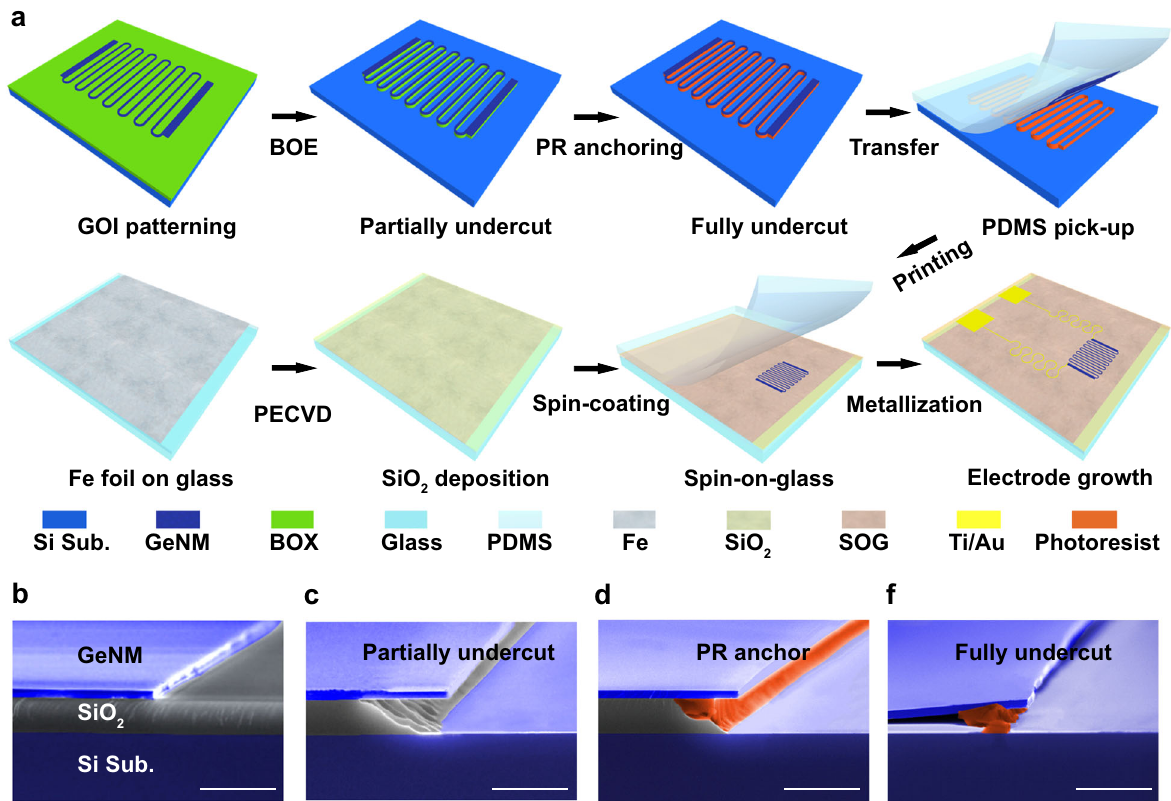
Fig. 3 Fabrication of the sensor. a Schematic illustration of key steps for the fabrication of biodegradable germanium nanomembrane-based sensors. b – e Pseudo-colored SEM images of a represented GOI at different fabrication steps, from left to right: photolithography and ICP-RIE de fi ne the germanium strip; partially undercutting the buried oxide layer realized by etching the buried oxide exposed and underneath the edge of strips in hydro fl uoric acid; the formation of photoresist anchor; fully undercutting the buried oxide layer to release the de fi ned germanium strips. Scale bar is 3 μ